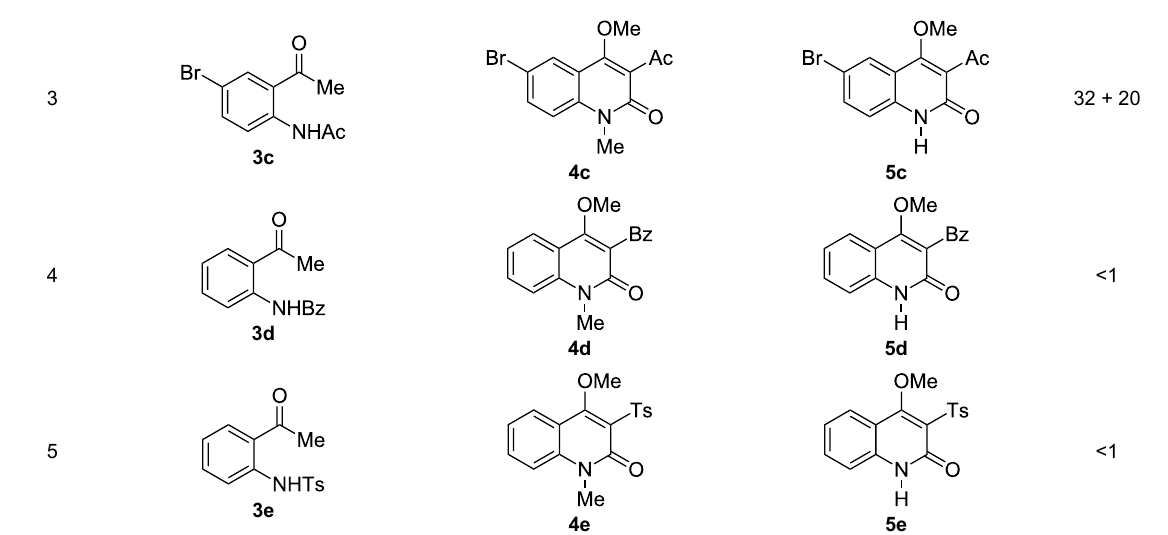
Table 3: Carboxylative cyclization of various o -acetamidoacetophenones with carbon dioxide. a